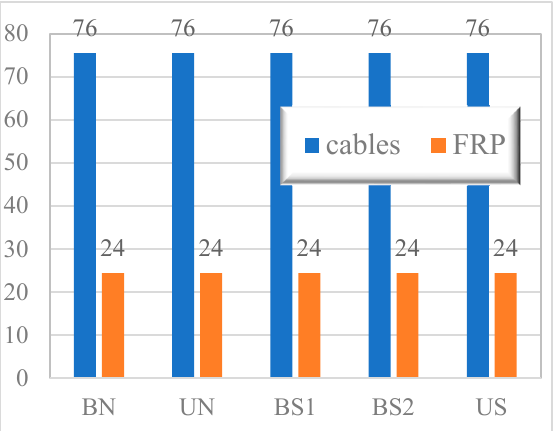
Figure 37. Strength contribution for one cable and one FRP laminate (1:1 ratio).